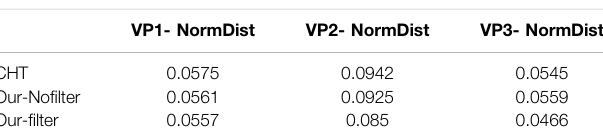
TABLE 7 | Comparison of average